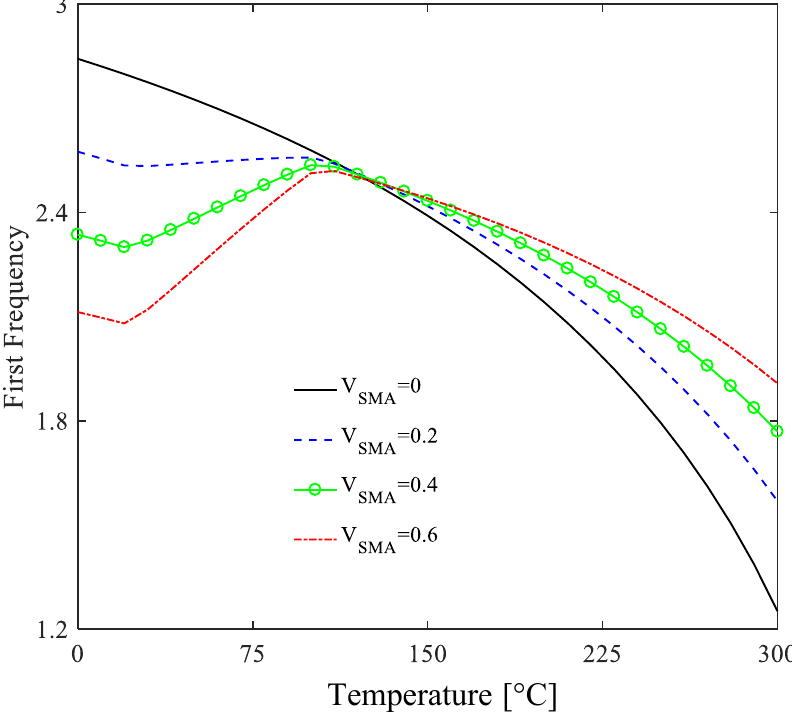
ℎ⁄ = 0.5 and 𝑛 = 1 ). = 0.2 , ℎ 𝑆𝑀𝐴 𝑐